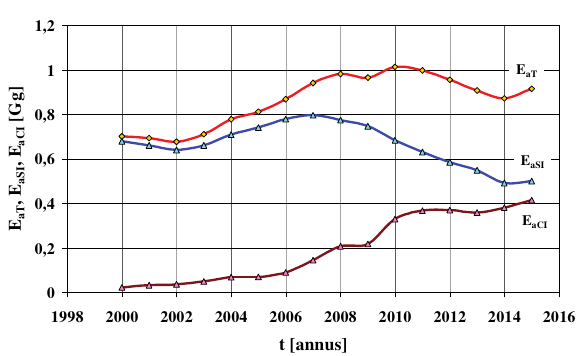
Fig. 10. National annual emission of nitrous oxide from passenger cars